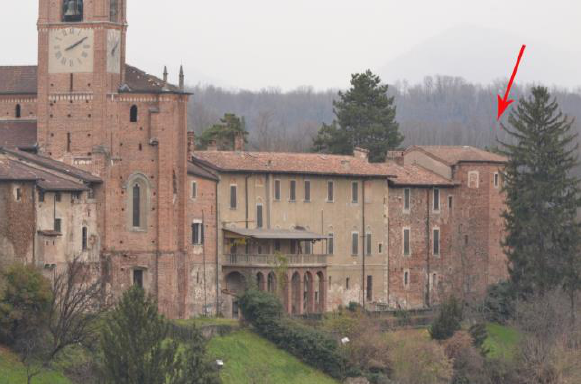
Figure 1: The ancient tower where the Baptistery is